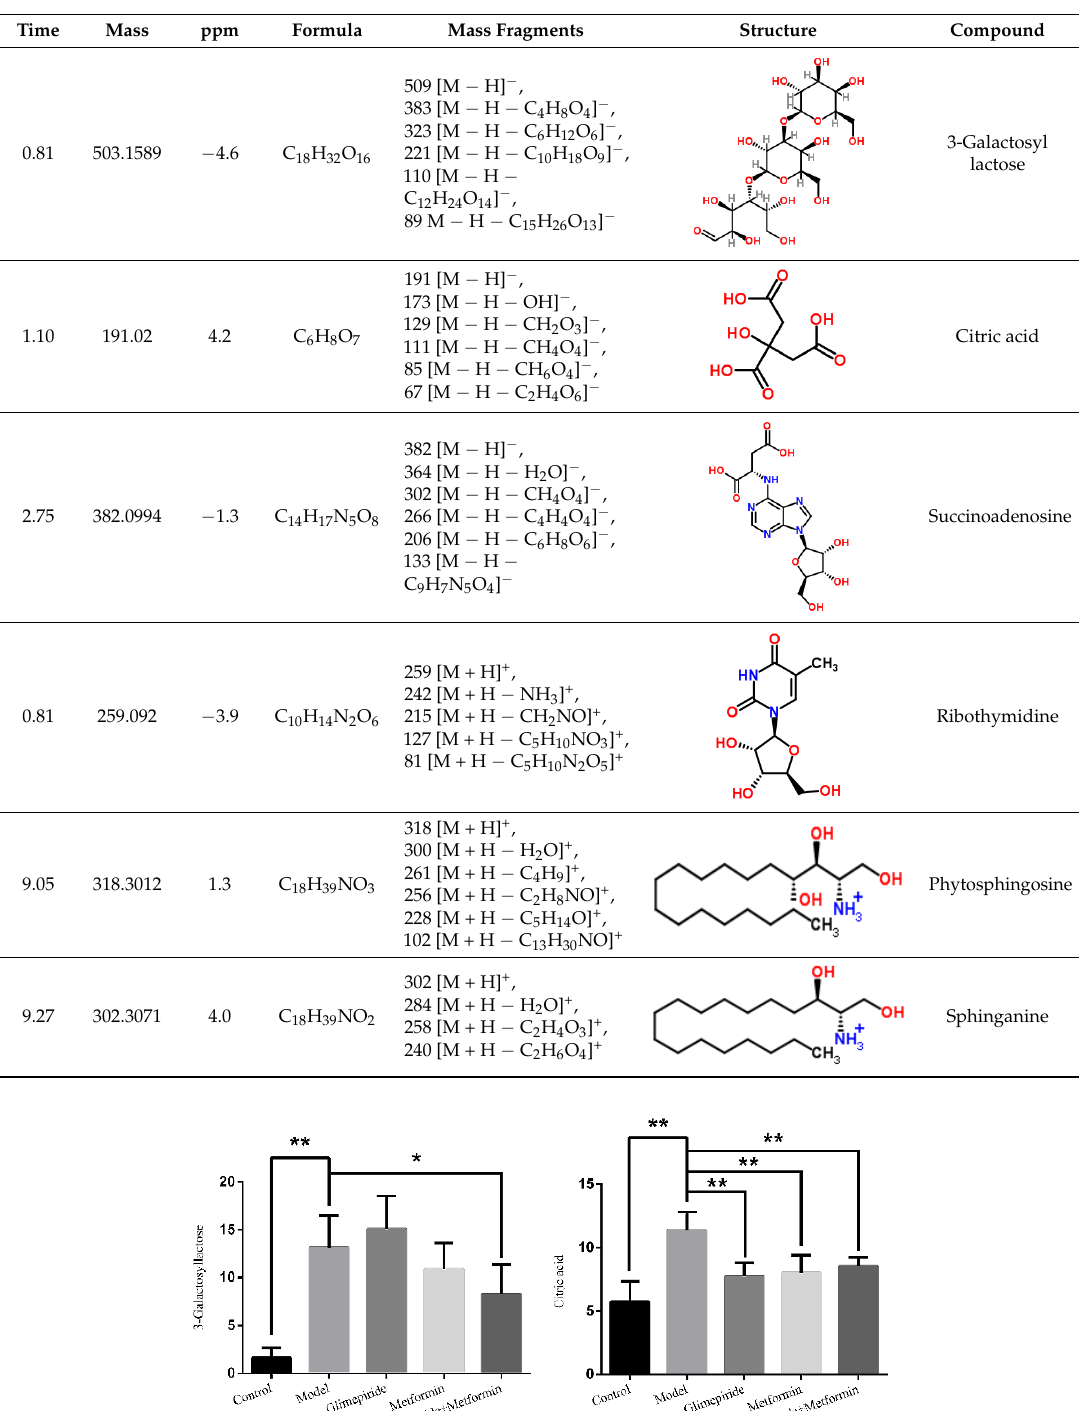
Table 2. Identified biomarkers in ZDF rat urine after treatment with glimepiride, metformin, and their combination compared with the model group. Table 3. Identified biomarkers in ZDF rat urine after treatment with glimepiride, metformin, and Table 3. Identified biomarkers in ZDF rat urine after treatment with glimepiride, metformin, and Table 3. Identified biomarkers in ZDF rat urine after treatment with glimepiride, metformin, and Table 3. Identified biomarkers in ZDF rat urine after treatment with glimepiride, metformin, and their combination compared with the model group. their combination compared with the model group. their combination compared with the model group. their combination compared with the model group. Table 3. Identified biomarkers in ZDF rat urine after treatment with glimepiride, metformin, and Table 3. Identified biomarkers in ZDF rat urine after treatment with glimepiride, metformin, and their combination compared with the model group. their combination compared with the model group.